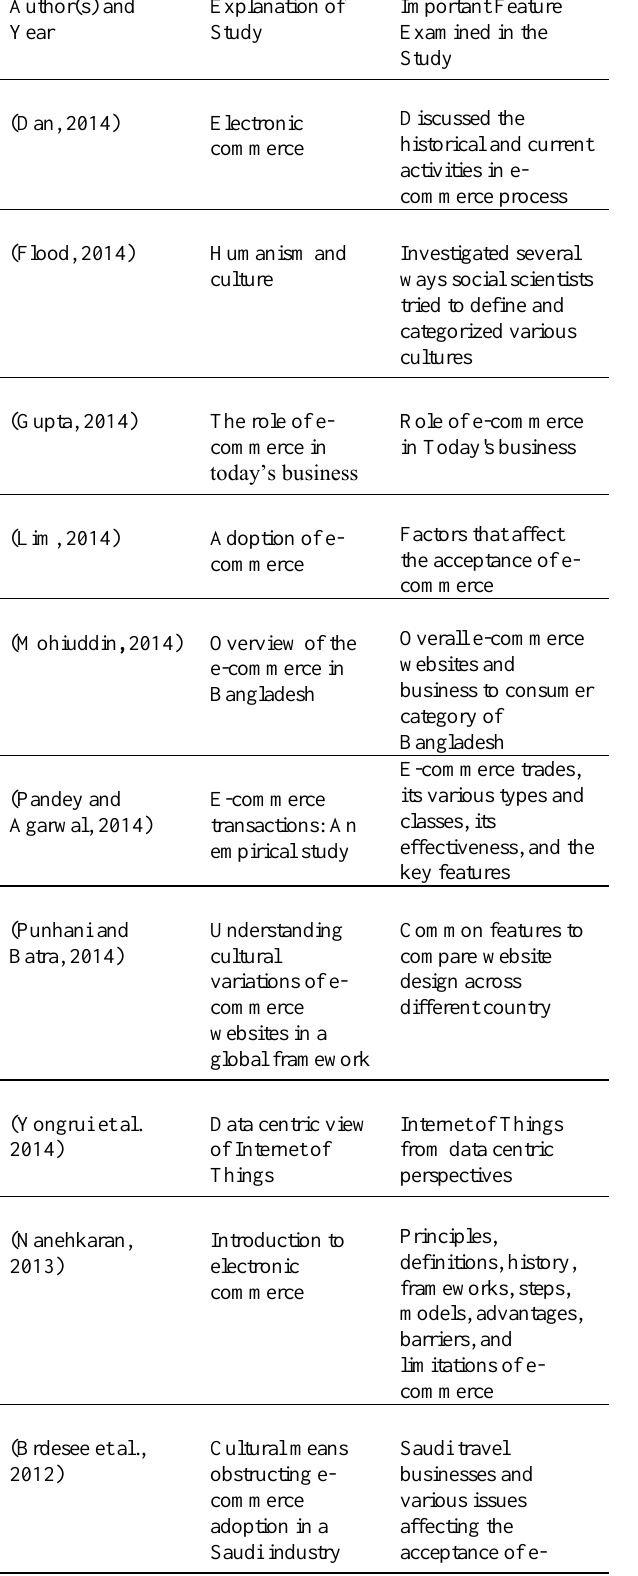
Table 3: A Summary of Selected Studies in Culture, E- commerce Website Design, and Narrative Review